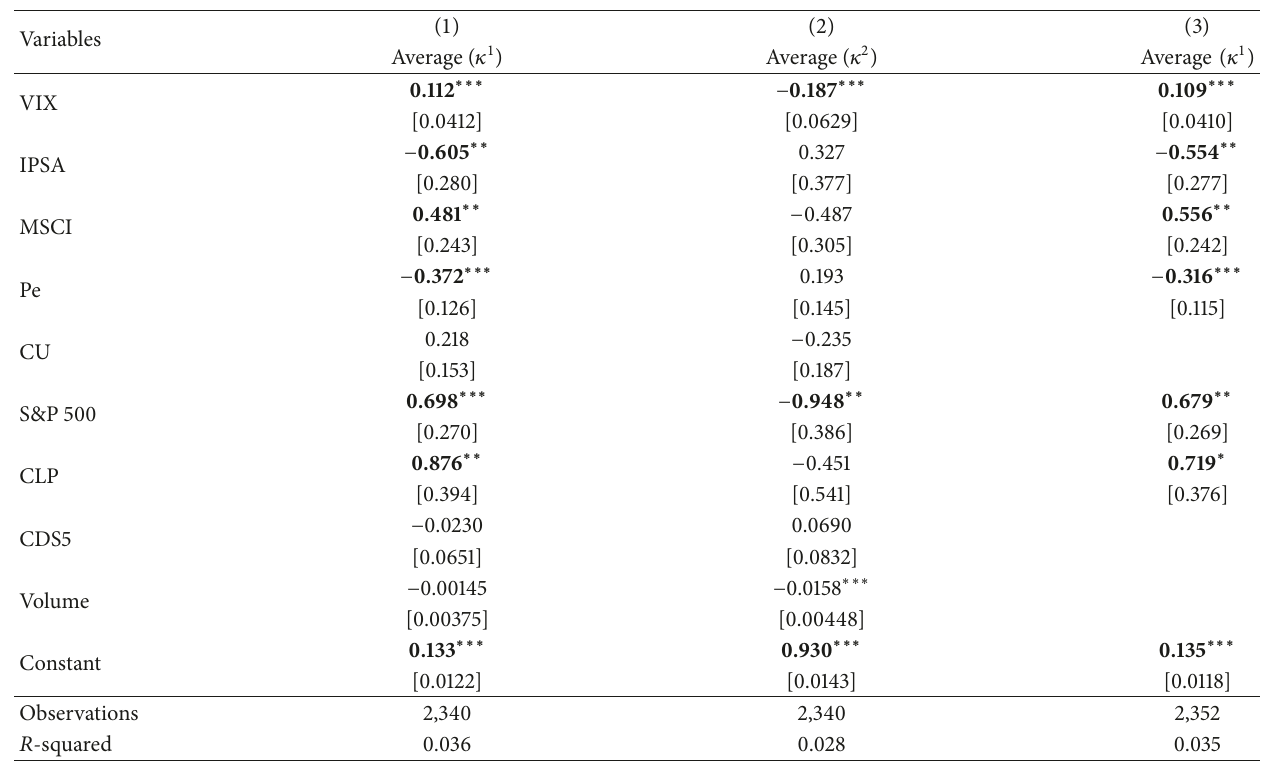
Table 1: Basic model. This table summarizes the results of the following basic model: 𝑦 𝑡 = 𝛼 + 𝛽 ∗ 𝑋 𝑡 + 𝑚 𝑡 + 𝑁 𝑡 + 𝜀 𝑡 . The dependent variable is the proposed index of network change, calculated using the average transaction as a threshold for the existence of a link. 𝑋 𝑡 corresponds to the returns or growth rate of variables such as IPSA, VIX, Pe, CU, CLP, S&P 500, volume, CDS5, and MSCI. 𝑚 𝑡 and 𝑁 𝑡 are month and year fixed effects to control for seasonality and variation associated with any specific year. Columns (1) and (2) show the results for the indexes 𝜅 1 𝑡 and 𝜅 2 𝑡 , and column (3) displays our preferred